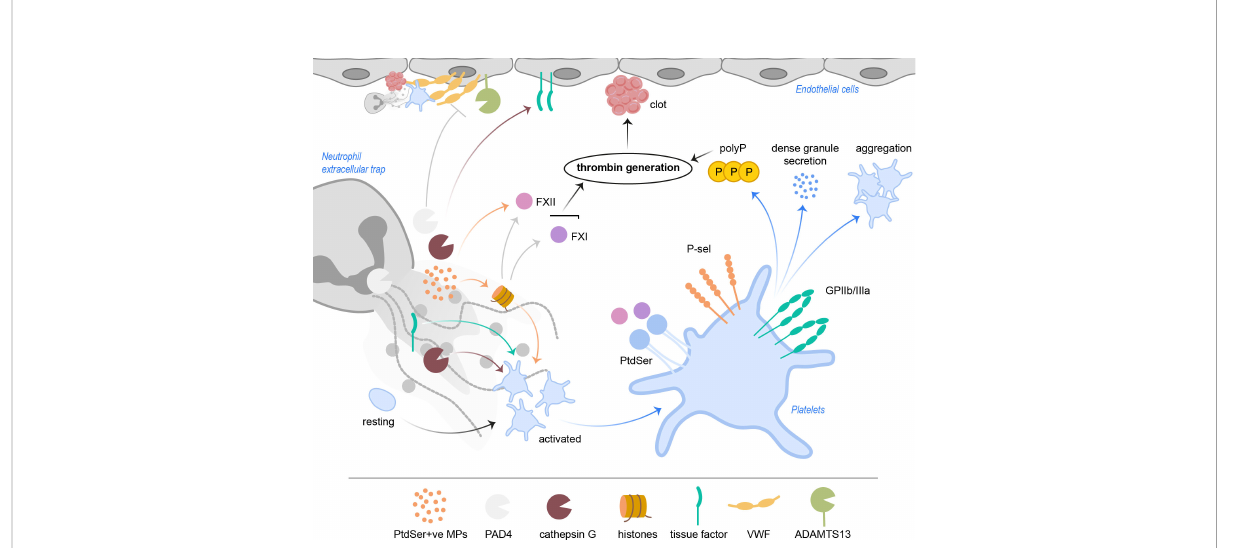
FIGURE 3 NETs activate platelets and drive coagulation. Cathepsin G and histones, especially H3 and H4, but also tissue factor directly activate platelets. PtdSer+ve microparticles in NETs provide a negatively charged surface, ideal for accumulation of coagulation factors. NETs with histones activate FXII and FXI, which results in thrombin generation. FXII and FXI also bind PtdSer exposed on platelets. Activated platelets increase P- selectin and GPIIb/IIIa activity, resulting in increased aggregation as well as signaling events leading to release of polyP and dense granule secretion. Ultimately, subsequent thrombin generation leads to clot formation in the vasculature. PAD4 was shown to inhibit ADAMTS13 activity, which hampers cleavage and removal of VWF strings. NET cathepsin G triggers tissue factor production in endothelial cells, further driving coagulation. ADAMTS13, a disintegrin and metalloproteinase with thrombospondin type-1 motif-1, member 13; FXII, factor XII; FXI, factor XI; GP, glycoprotein; MPs, microparticles; PAD4, peptidylarginine deiminase 4; PtdSer, phosphatidylserine; P-sel, P-selectin; polyP, inorganic polyphosphate; VWF, von Willebrand